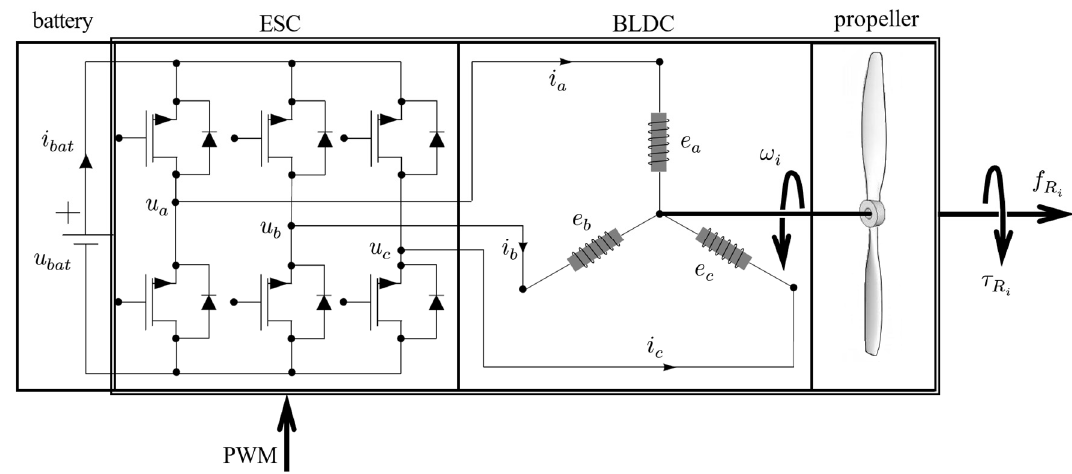
Figure 3. Electric propulsion unit (EPU) schematic.